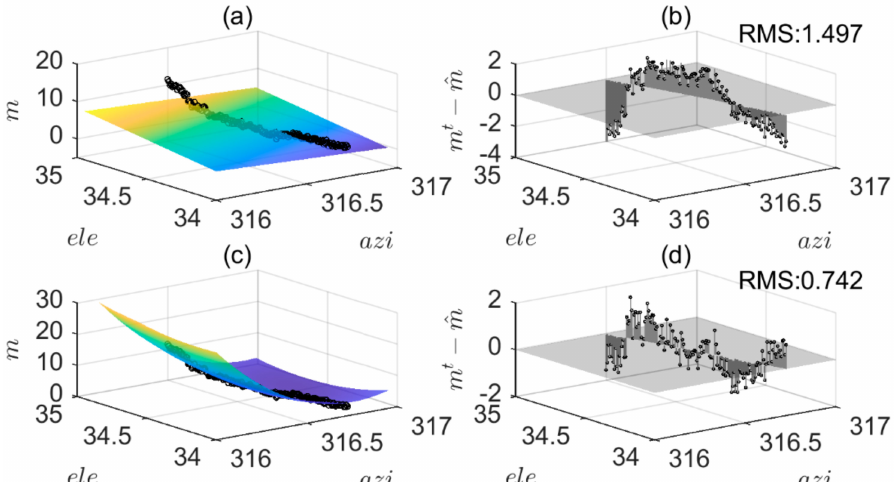
Figure 3. Constrained trend surface fitting results of grid (35, 317). ( a ) Linear trend surface fitting with constraints. ( b ) Residual plot of target multipath value m t minus constrained linear fitting trend surface fitting ˆ m . ( c ) Quadratic trend surface fitting with constraints. ( d ) Residual plot of target multipath value minus constrained quadratic trend surface fitting. X, Y-axis unit: degree, Z-axis unit: